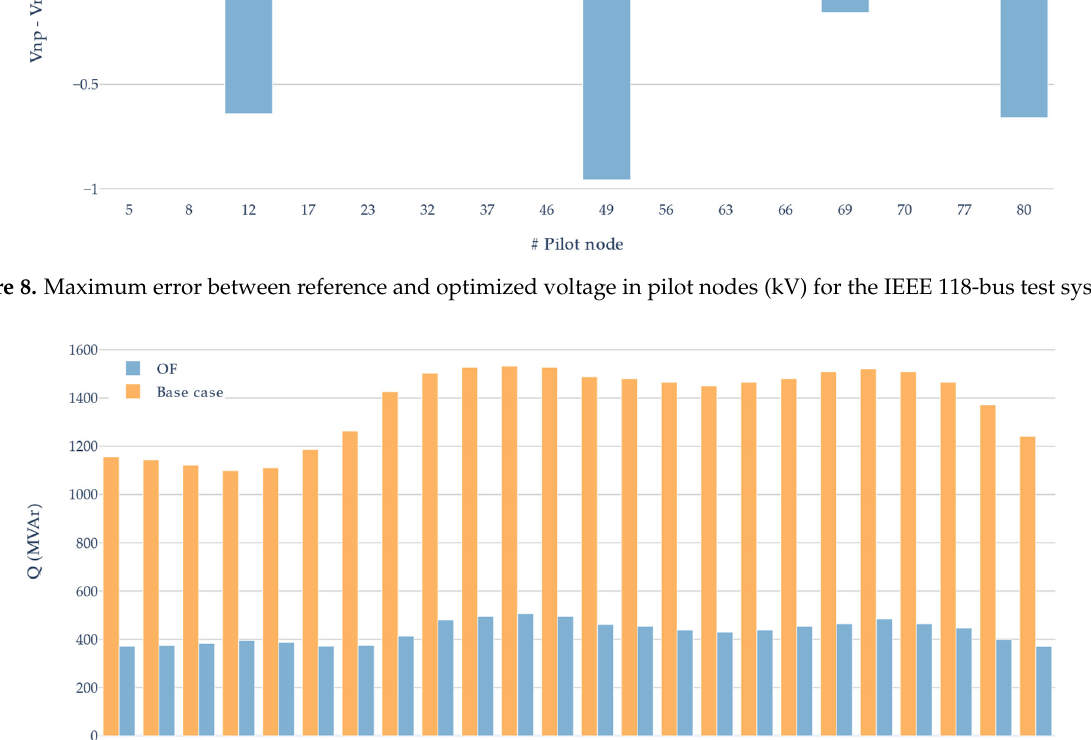
Figure 9. Absolute reactive power output of generators for each period for the IEEE 118-bus test system.